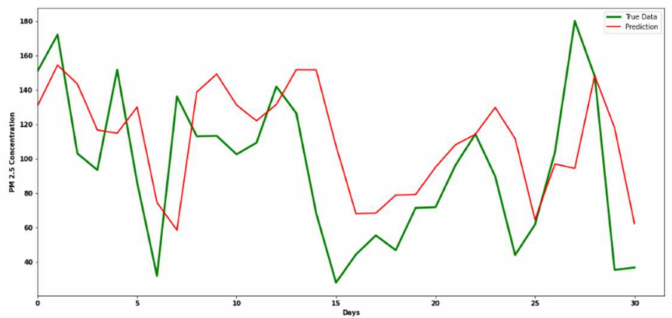
Figure 25. Forecasting for the next month for Karachi using the LSTM model.